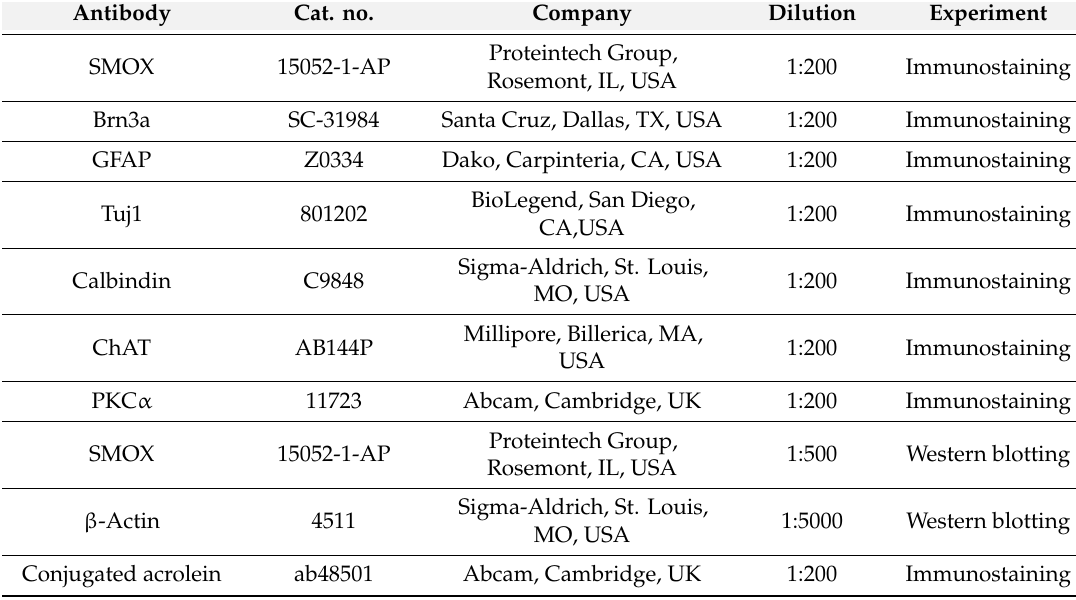
Table 1. Antibodies used in the